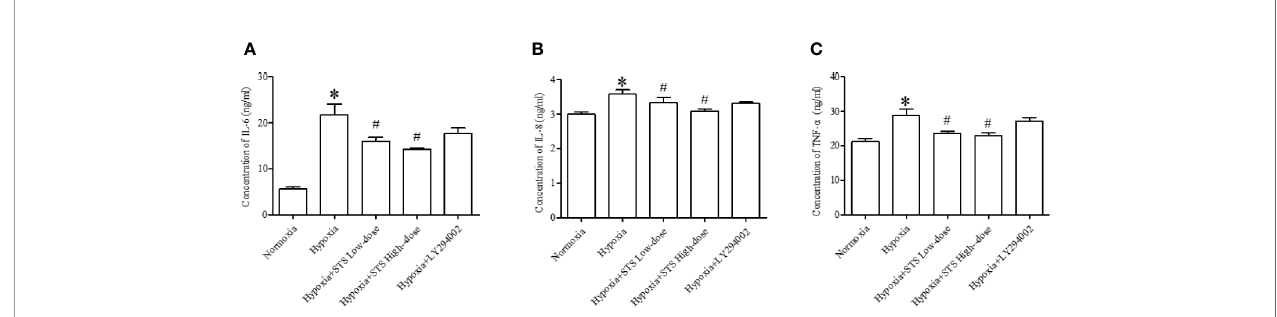
FIGURE 7 | Content of in fl ammatory factors in each group. (A) IL-6, (B) IL-8, (C) TNF- a . Each bar presents the Mean ± SEM, n = 5-8. * P < 0.05 compared with the normoxia group, # P < 0.05, compared with the